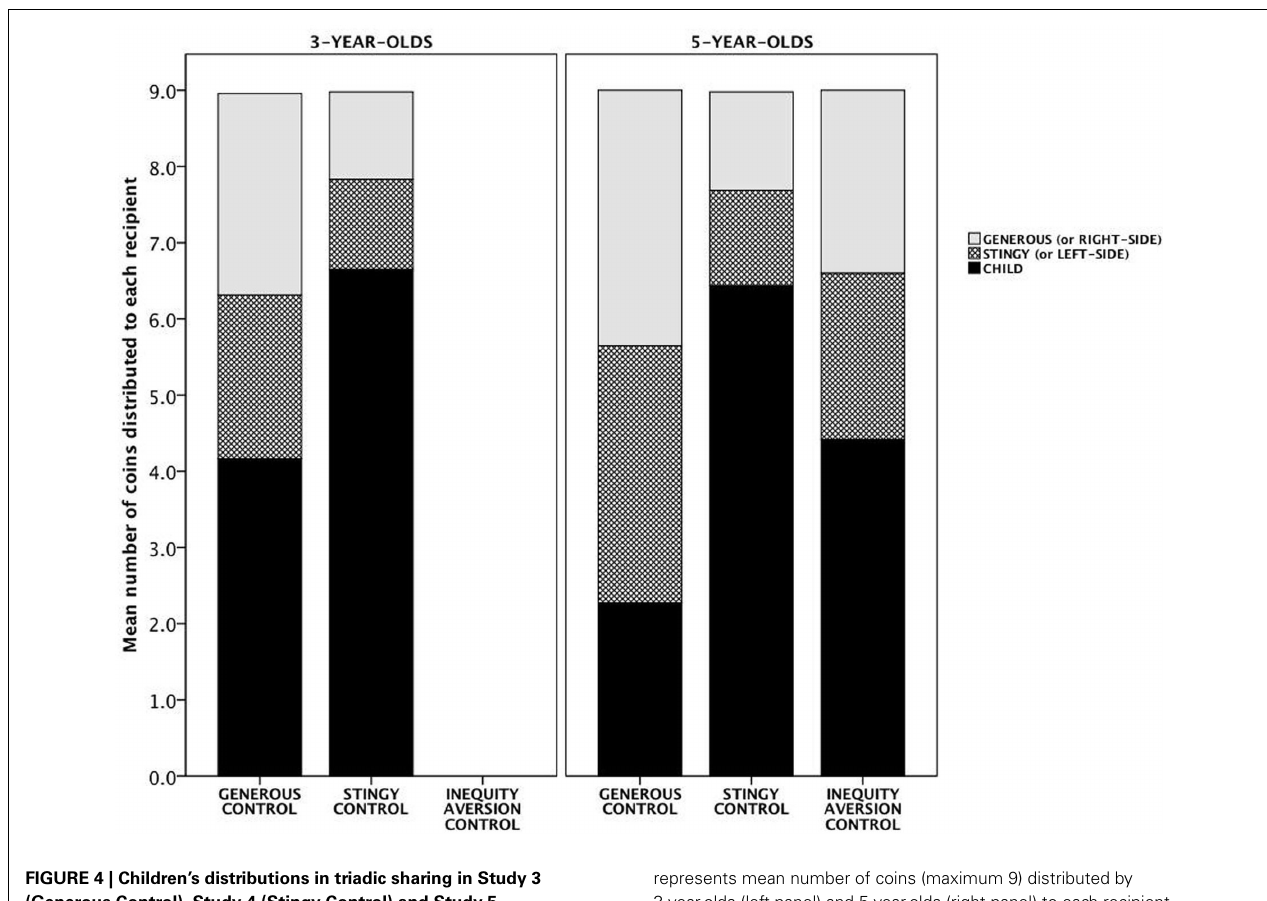
FIGURE 4 | Children’s distributions in triadic sharing in Study 3 (Generous Control), Study 4 (Stingy Control) and Study 5 (Non-Agentive Control). Children split coins between themselves and two puppets that were either identically generous (Study 3), or stingy (Study 4), or were passive recipients of the game (Study 5).Vertical axis